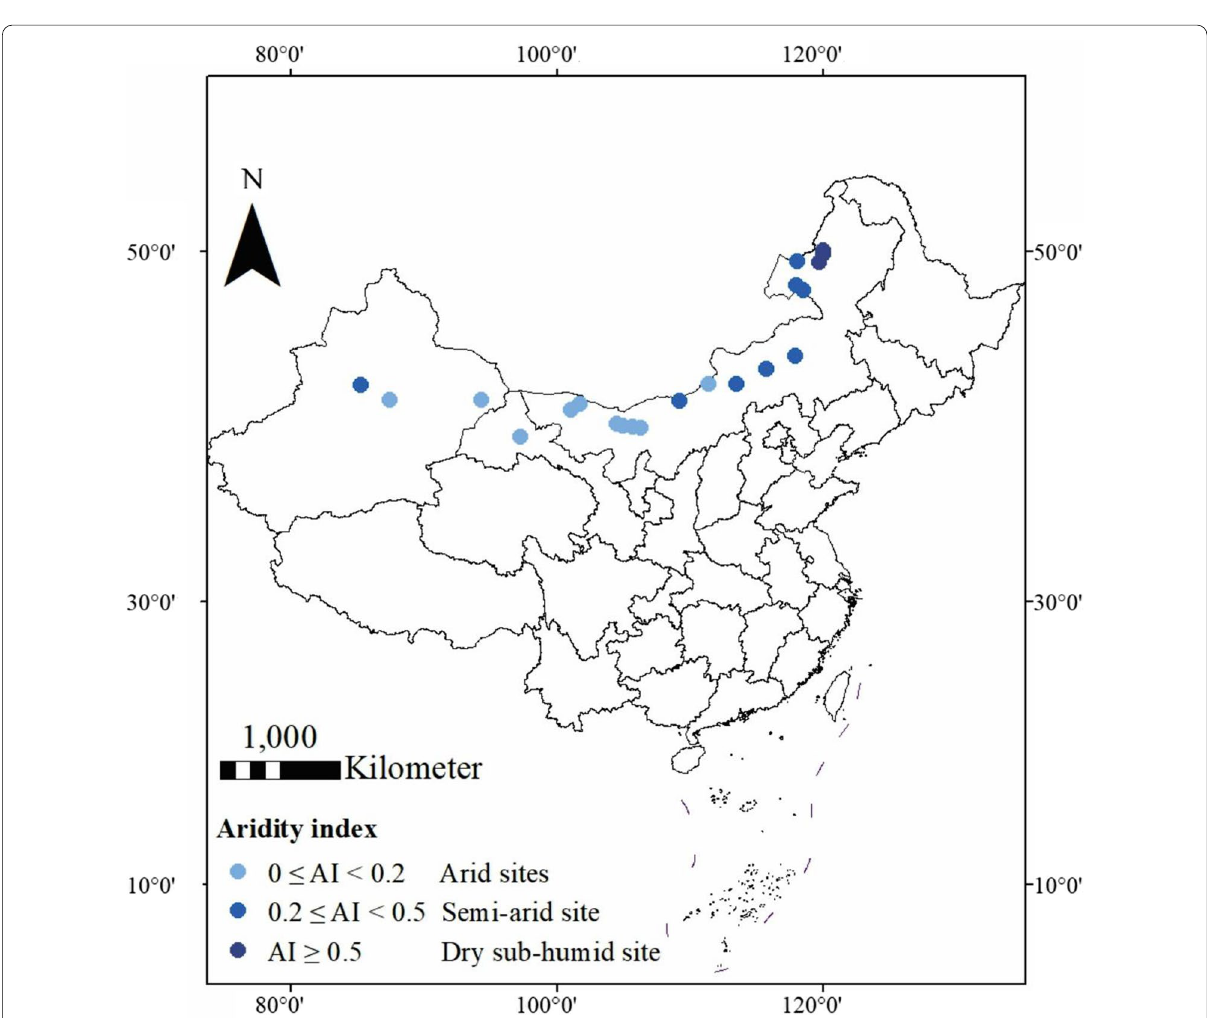
Fig. 1 Map of sampling localities on a continental scale. Across northern China from west to east, the sampling sites are labeled S01–S21 in order. Based on the aridity index (AI), the sites are divided into three climate subtypes: arid areas (0 areas (0.2 < AI 0.5, represented by blue circles), and dry sub‑humid areas (AI ≤